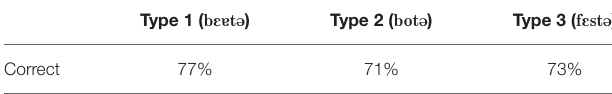
TABLE 8 | Proportions of correct answers of words in Experiment 2.